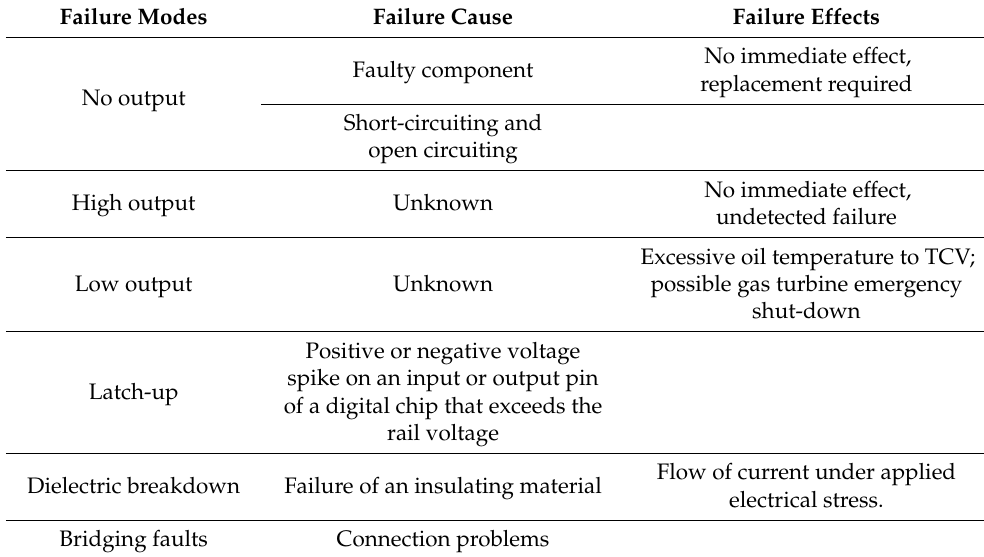
Table 1. Failure modes, causes, and effects in the non-intrusive continuous sensor.